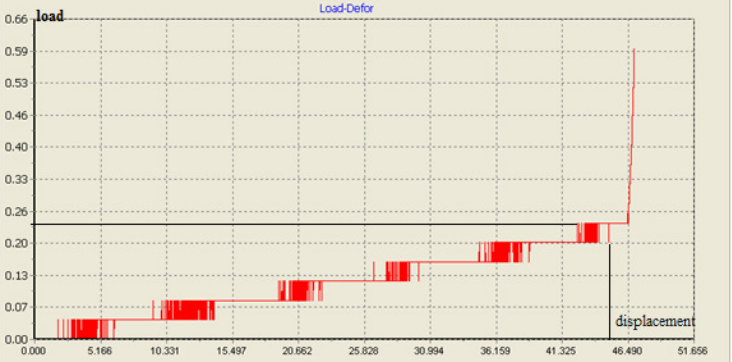
Fig. 6. load-Deformation Test Result.